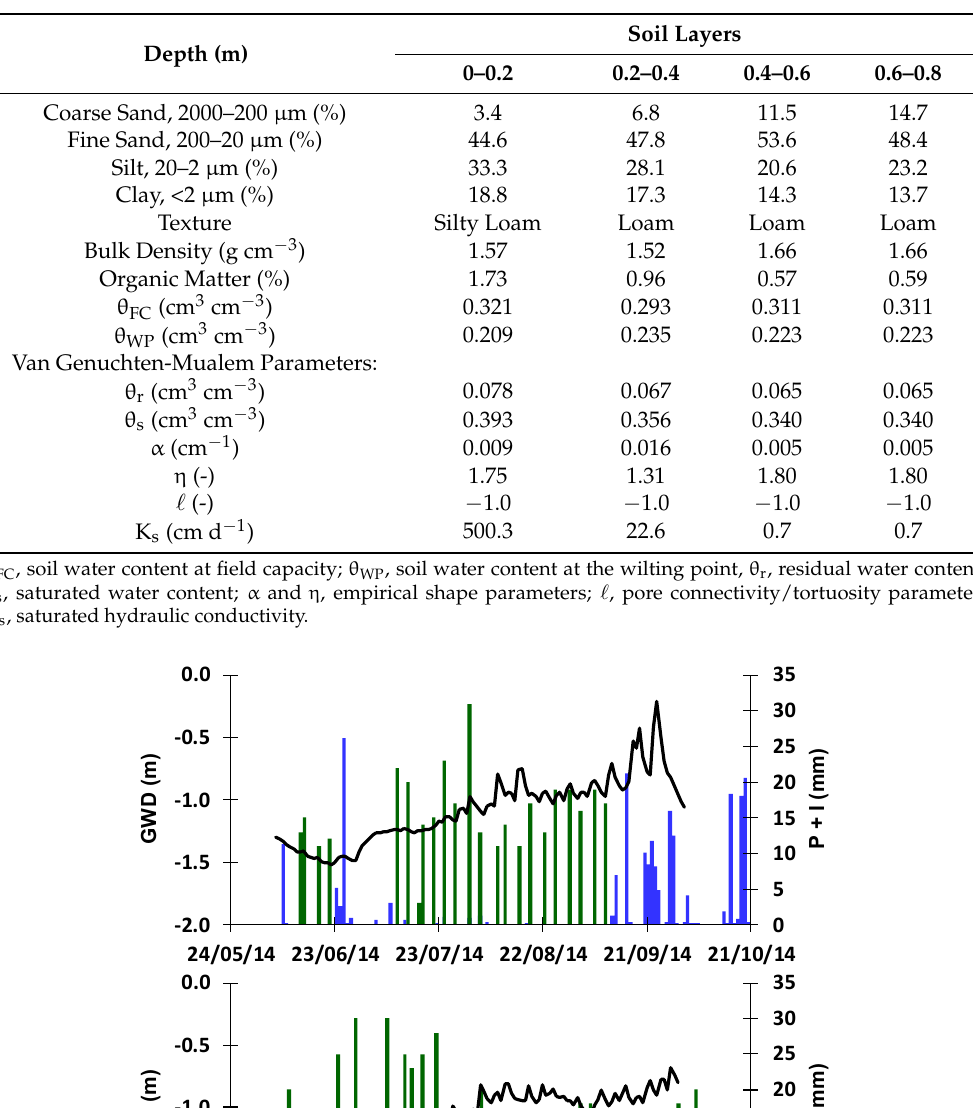
Table 1. Main physical and chemical soil characteristics.